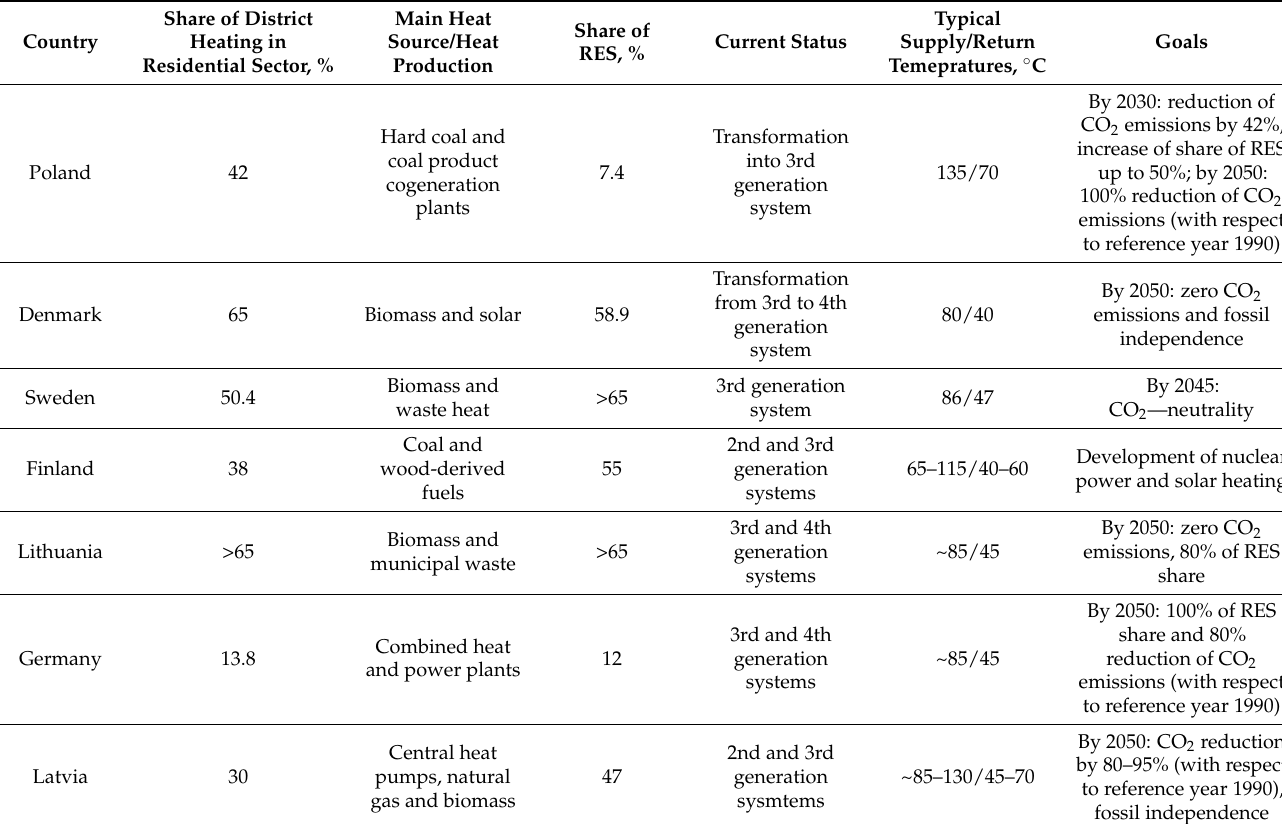
Table 1. Current status of district heating systems in selected Baltic Sea countries—a summary. Country